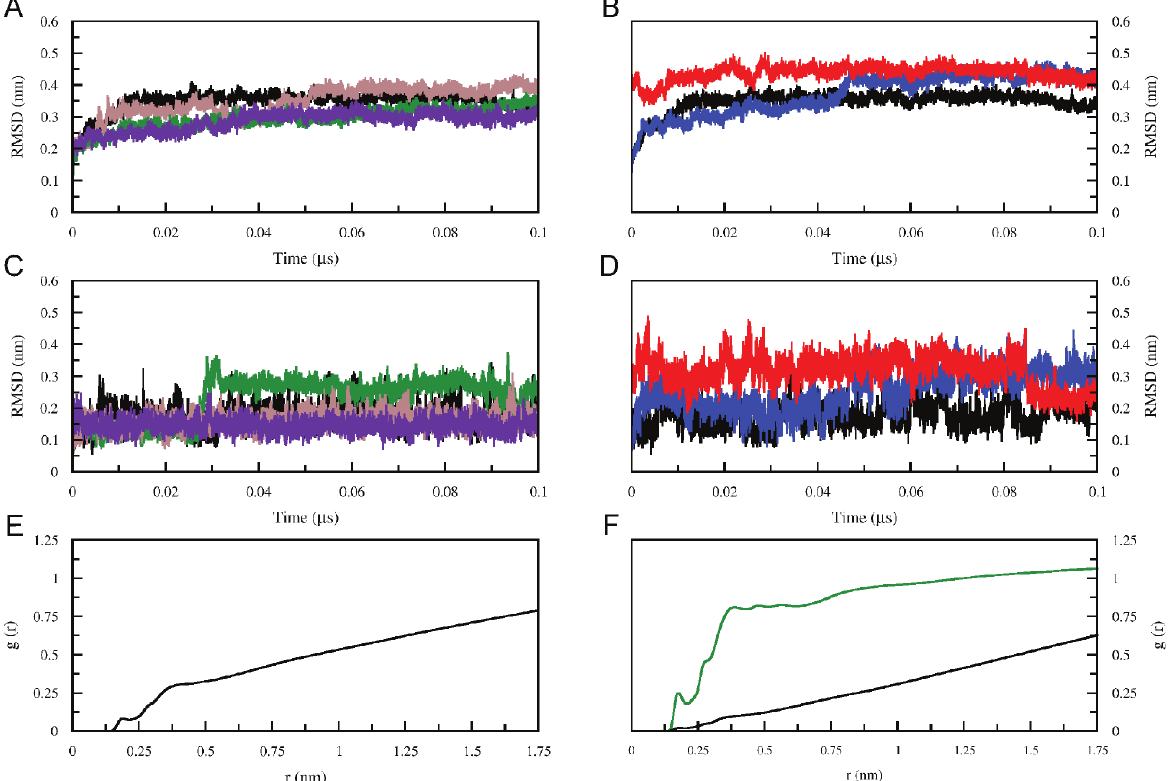
Figure 2 - MD analyses as a function of time for Systems 1 (brown), 2 (indigo), 3 (black), 4 (blue), 5 (red), and 6 (green). All-atom RMSD from crystal structure is shown in (A) and (B) for entire protein, and in (C) and (D) for residues from the C-terminal α-helix. A comparative radial distribution function (RDF) of water molecules around StnII in System 3 and System 6 (black curve in E and F, respectively) and urea molecules around StnII in System 6 (green curve in